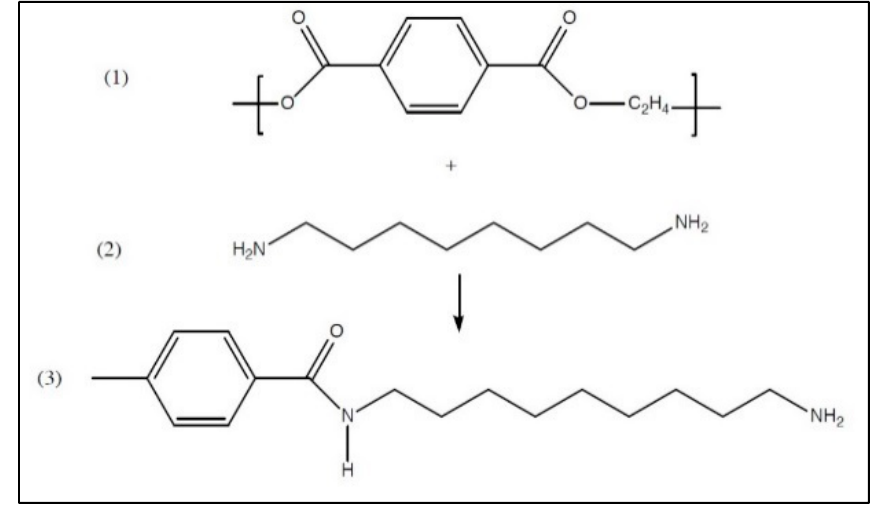
Figure 15. Aminolysis of PET.